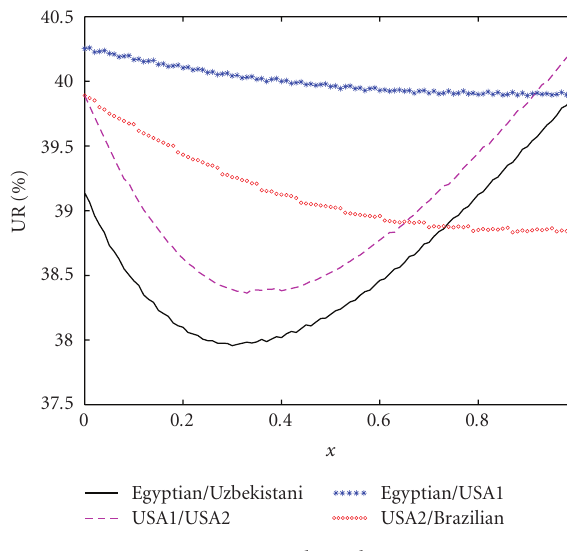
Figure 14: UI% dependence to x .